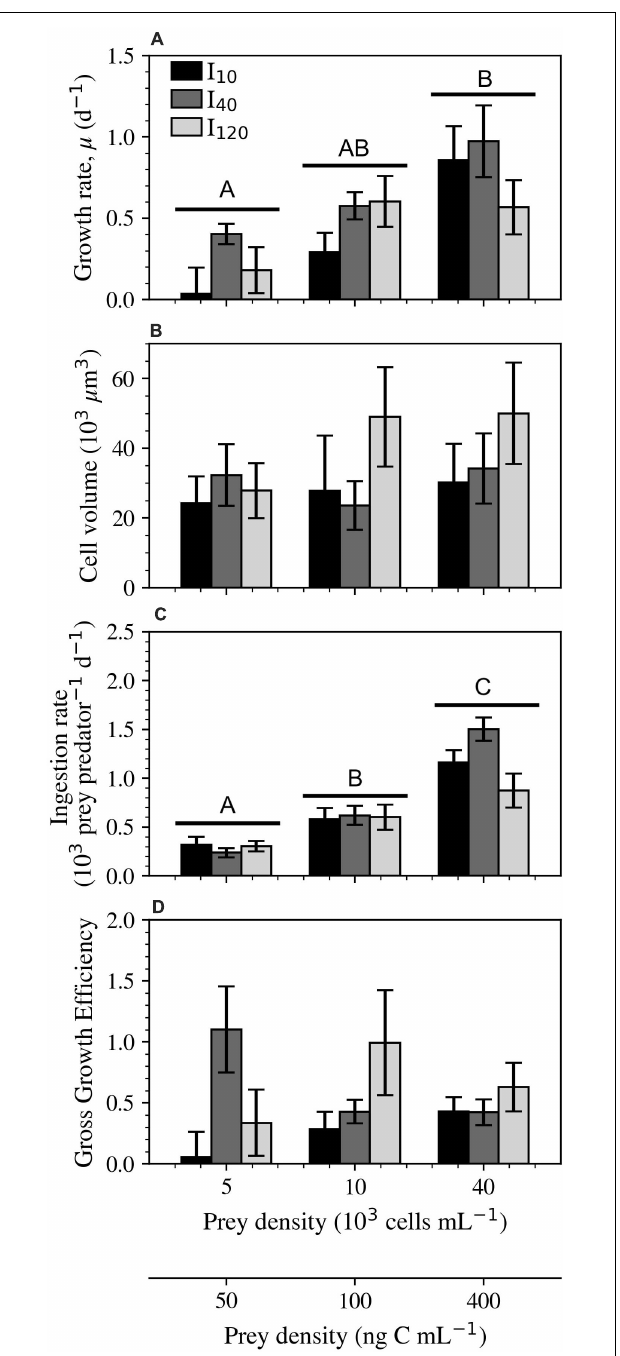
FIGURE 4 | Experiment 2: Physiological responses of Strombidium cf. basimorphum at the three light (I 10 , I 40 , and I 120 ) and three prey density treatments (50, 100, and 400 ng C mL − 1 ). (A) Growth rate ( n = 9). (B) Biovolume of Lugol-fixed ciliate cells ( n = 90). (C) Ingestion rate ( n = 9). (D) GGE ( n = 9). Black, dark gray, and light gray bars denote light treatments I 10 , I 40 , and I 120 , respectively. Data points are means ± STD. Irradiance was not proven to be statistically significant for any of the displayed variables; the letters, therefore, represent statistically similar groupings based only on the overall effects of prey density across all irradiance treatments. Subplots without letters did not show significant effects of prey density or